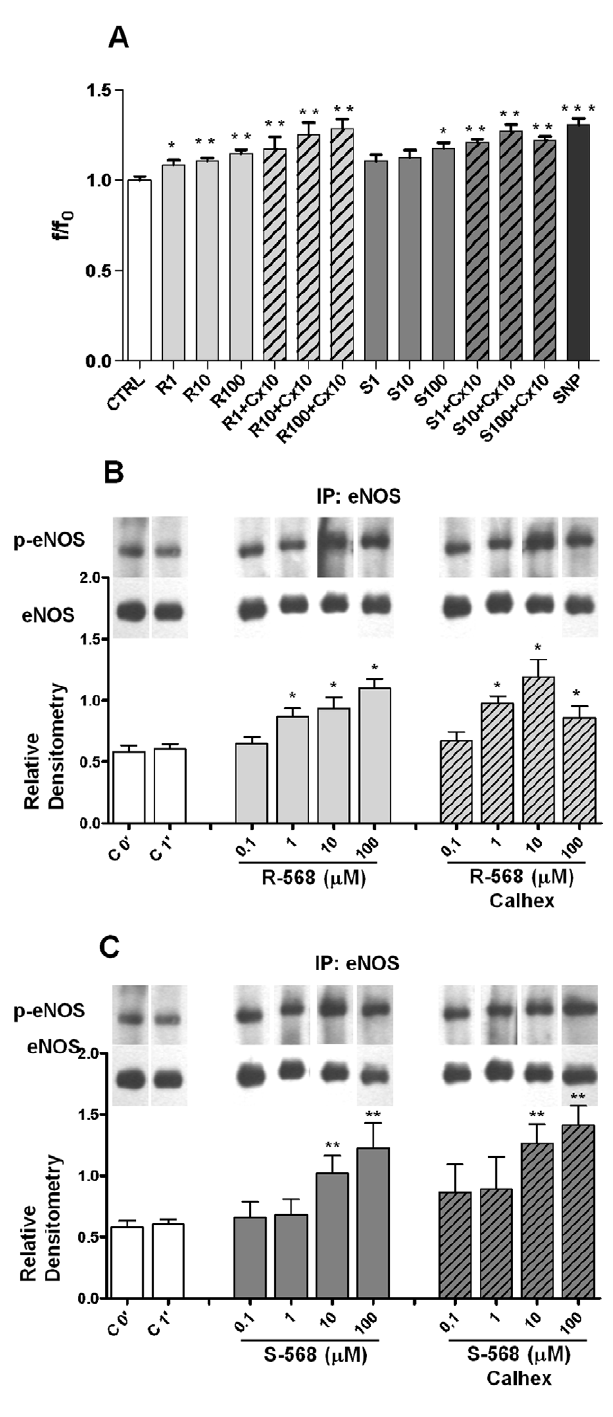
Figure 4. Effects of R-568 or S-568 + /- Calhex (10 m M) on HUVECs NO production. NO levels (mean value 6 SE) in DAF-2DA- loaded HUVEC populations treated with R-568 or S-568 (1–100 m M) + /- Calhex 10 m M (A). eNOS-ser1177 phosphorylation in HUVECs stimulated with R-568 (B) or S-568 (C) (0.1–100 m M) + /- Calhex (10 m M). Representative immunoblot of eNOS-ser1177 phosphorylation (Upper Panel, B and C). Representative data from three experiments (means 6 SD, Lower Panel, B and C). Phospho-eNOS (p-eNOS) expression was normalized vs total eNOS expression.